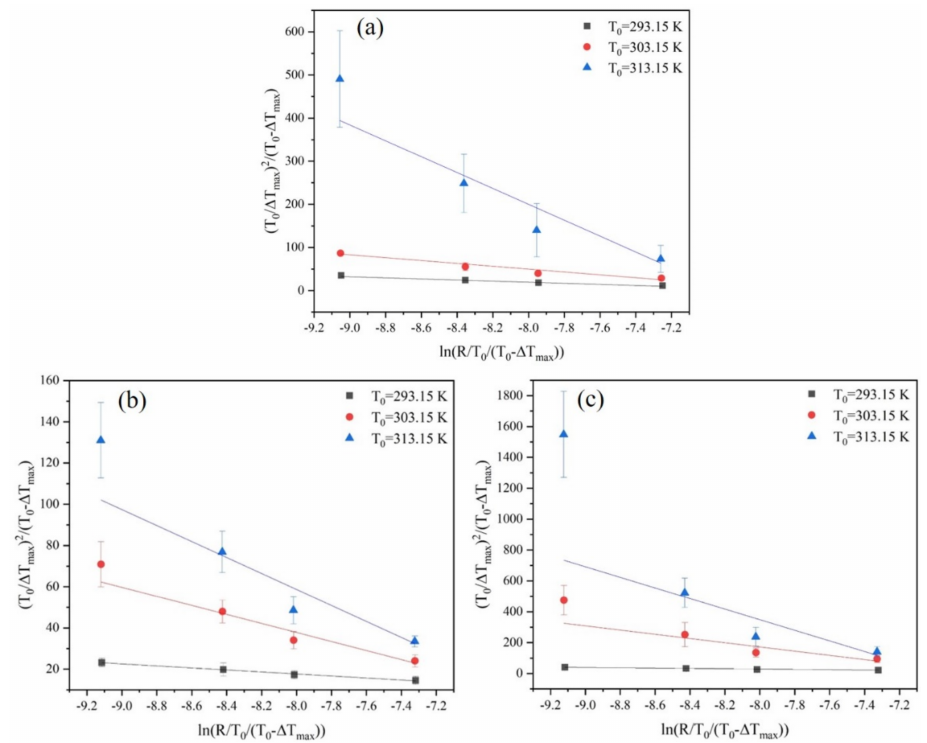
Figure 9. Relationship between MSZW and cooling rate at different T 0 fitted by the modified Sangwal model: ( a ) ethanol mass fraction of 0.6, ( b ) ethanol mass fraction of 0.8, and ( c ) ethanol mass fraction of